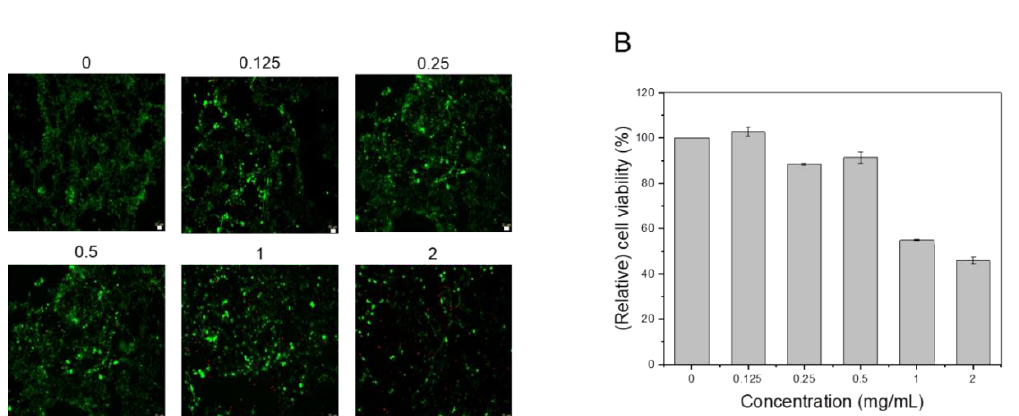
Figure 7. ( A ) Live/dead fluorescence imaging of the cultured cells and ( B ) cytocompatibility examined using a WST assay for various NP concentrations.